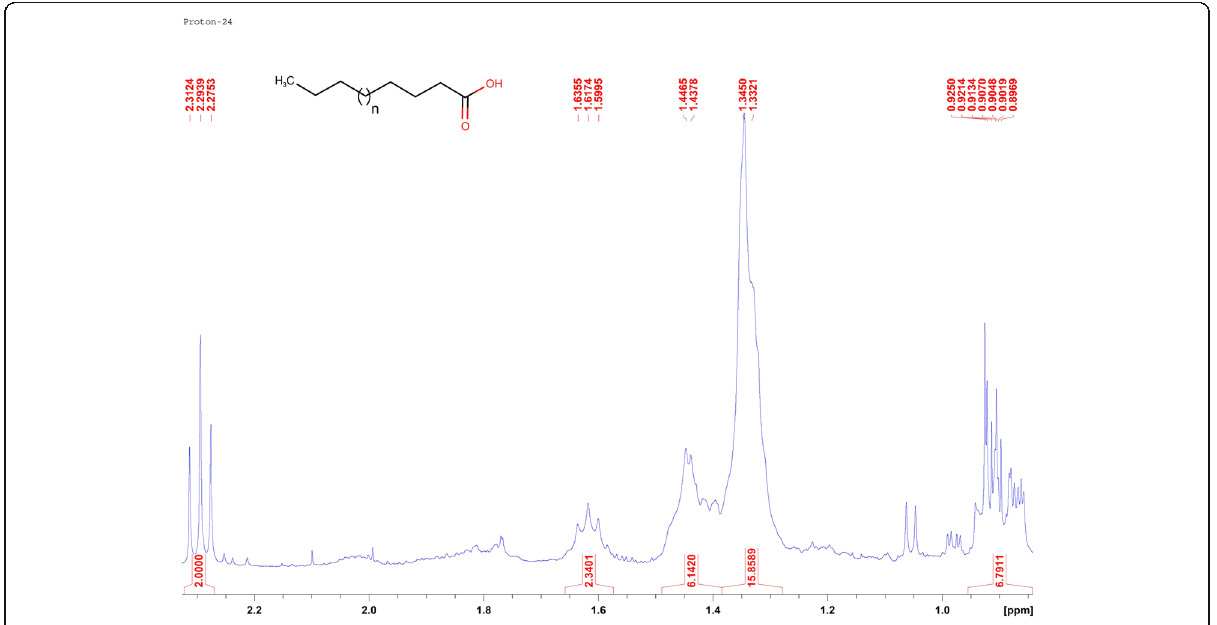
Fig. 6 1 H NMR spectroscopy of the major compound in fraction 24 in